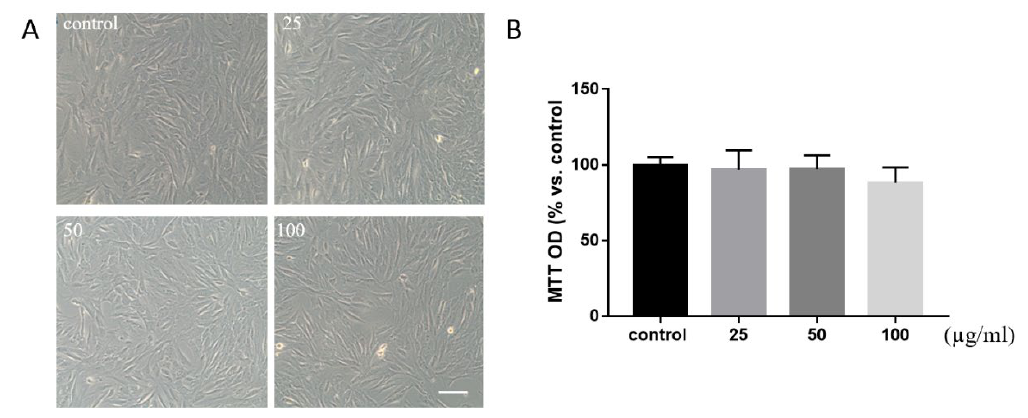
Figure 2. Toxicity of RMN on cells. ( A ) C2C12 myoblast cells showed no difference in growth or quantity compared to the control group from the contrast image. ( B ) The data showed there were not any significant changes after treating by a range concentration of RMN. Scale bar: 100 µ m. Statistical analysis was performed with one-way ANOVA with Dunn’s test for multiple comparison.